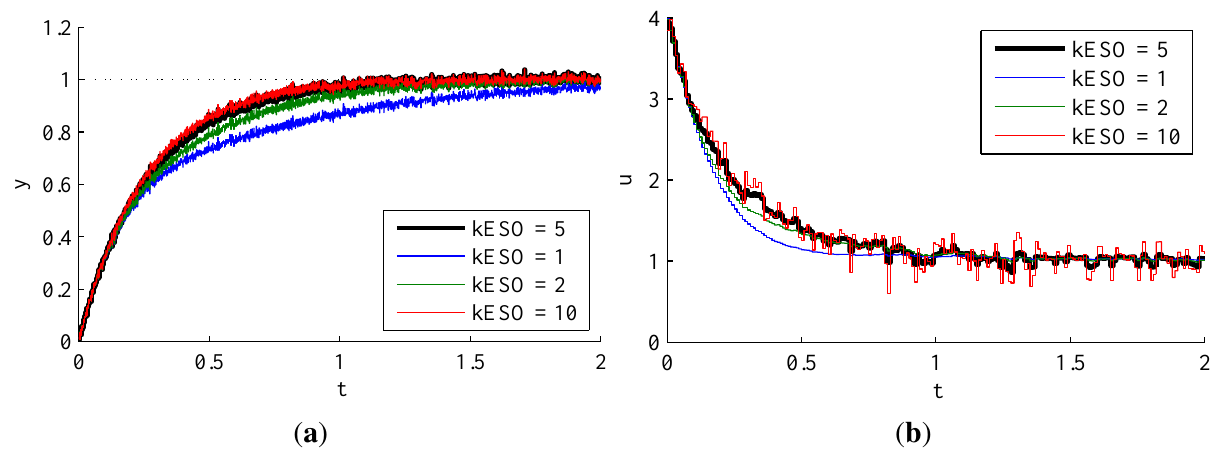
Figure 20. Experiment 4.2.3: influence of observer pole placement via k = 0 . 01. Measurement noise variance: σ 2 ADRC. Sample time: T sample Variation of k , closed loop step response; ( b ) Controller output u for ( a ESO